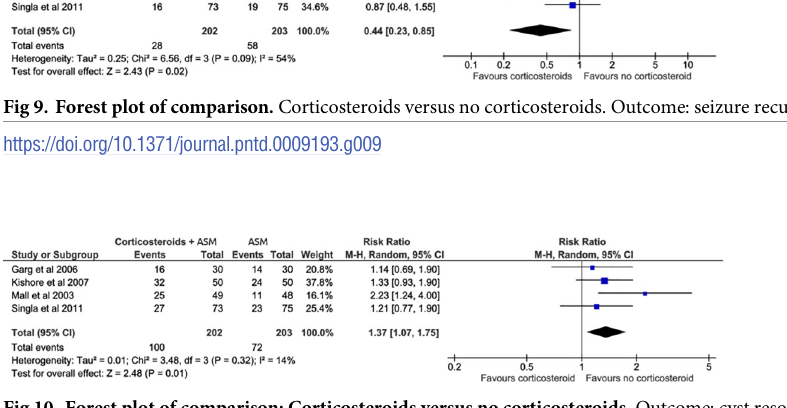
Fig 10. Forest plot of comparison: Corticosteroids versus no corticosteroids. Outcome: cyst resolution without calcification.